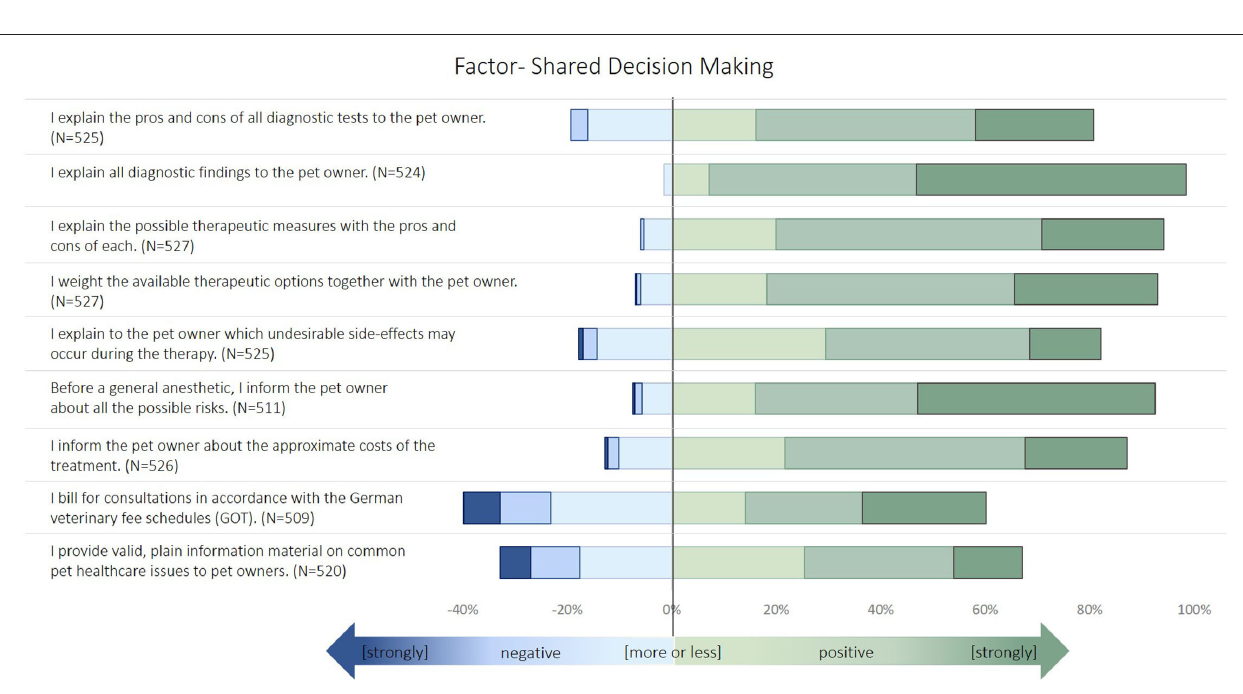
FIGURE 4 | Description of the items used to build the factors relating to self-estimation and perceived relevance for success in the